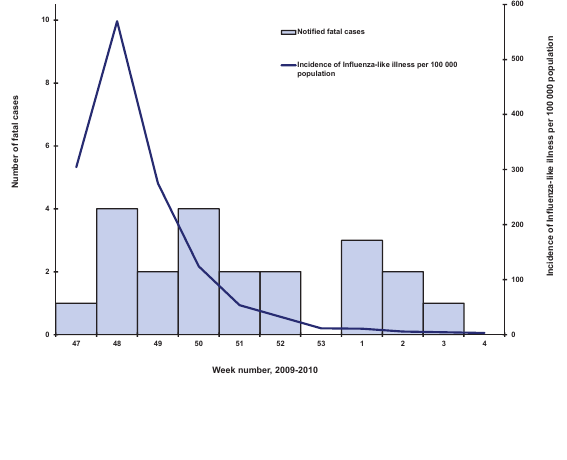
Figure 1: Epidemic curve: start of influenza pandemic in Lithuania, the first wave and beginning of the second wave (individual, case - based reporting).